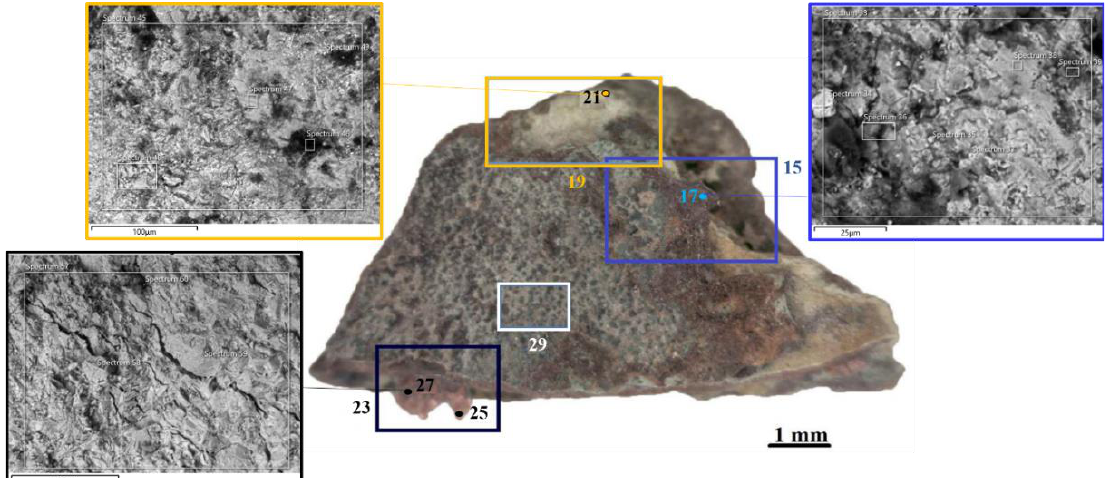
Figure 12. Schematic of the areas investigated by SEM-EDS for sample 20. Area 15, colored in blue, presented the green patina and an underlying orange and detail 17, colored in light blue, was the rust-colored area. Area 19, colored in yellow, included a green patina and a white patina which was then further investigated in the detail 21. Area 29, colored in white, presented a thick green patina with a pitted appearance. Finally, a thin layer of copper color (area 23, colored in black) and two different details 25 and 27. SEM images are related to detail 17 (in blue), detail 21 (in yellow) and detail 27 (in black).